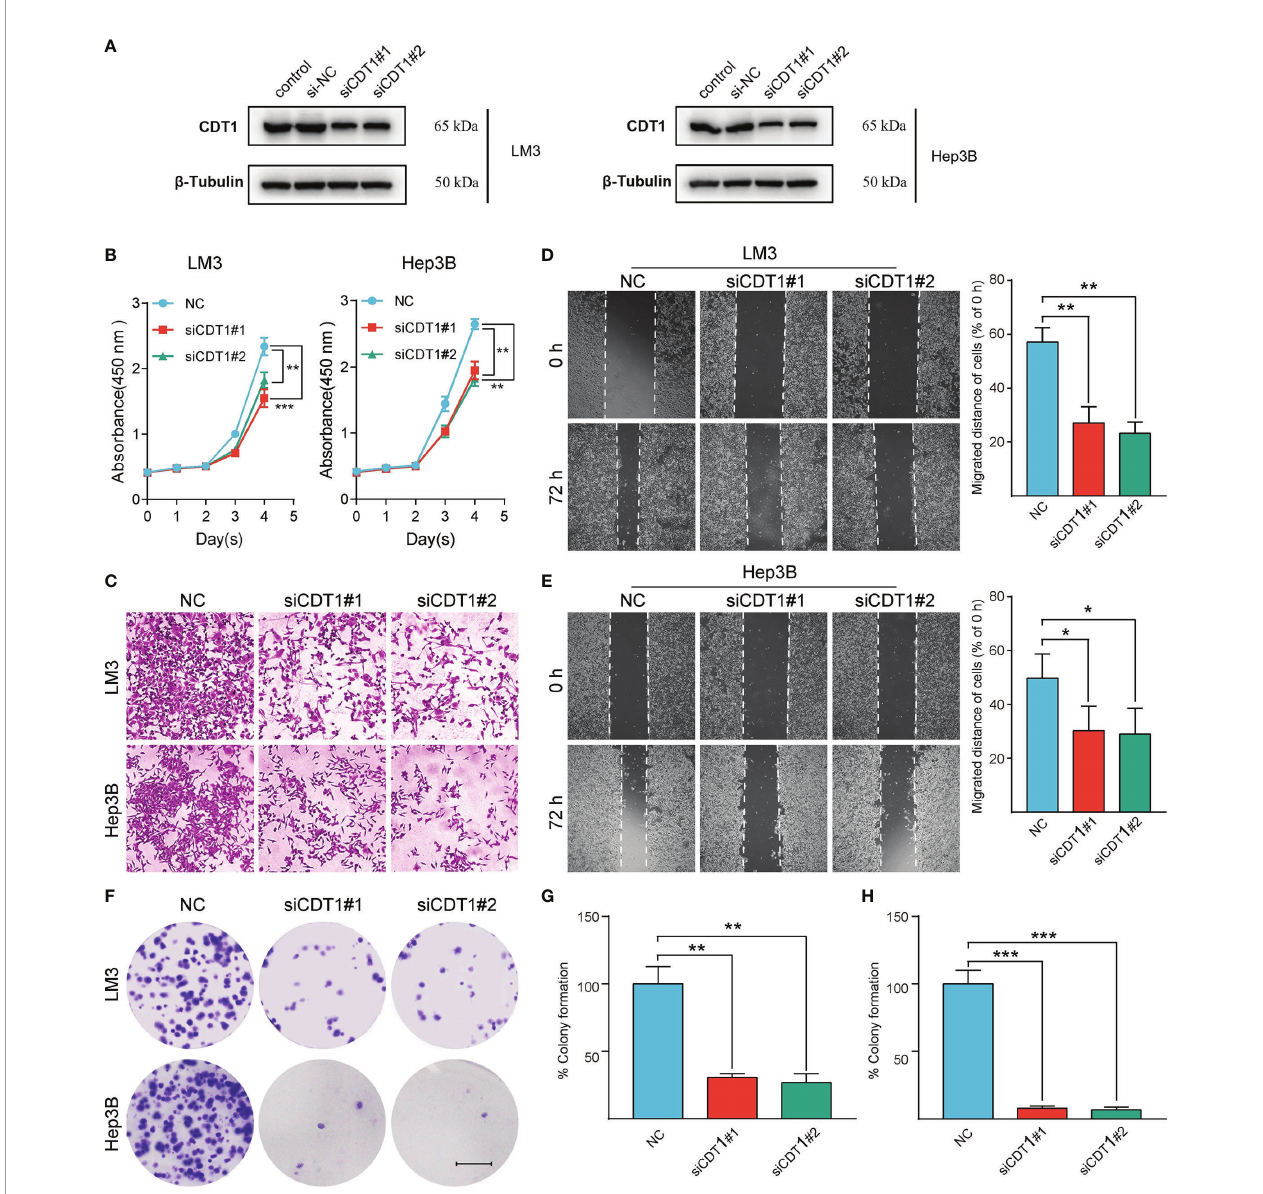
FIGURE 11 | Silencing of CDT1 inhibited the proliferation, migration and invasion of HCC cells. (A) Western blot detection of CDT1 expression after knockdown of CDT1 in liver cancer cells. (B) The effect of CDT1 knockdown on cell viability at 24, 48, 72 and 96h after seeding in plates was measured by CCK-8 assay. (C – E) Transwell analysis and wound healing assay re fl ected the migration ability of LM3 and Hep3B cell lines. (F) Images of the colony formation assay after knockdown of CDT1 in HCC cells (G, H) Relative quanti fi cation of the colony areas is shown. Scale bars in (F) equal 5mm. Data are expressed as means ± SD of three independent experiments. * p < 0.05, ** p < 0.01, *** p <